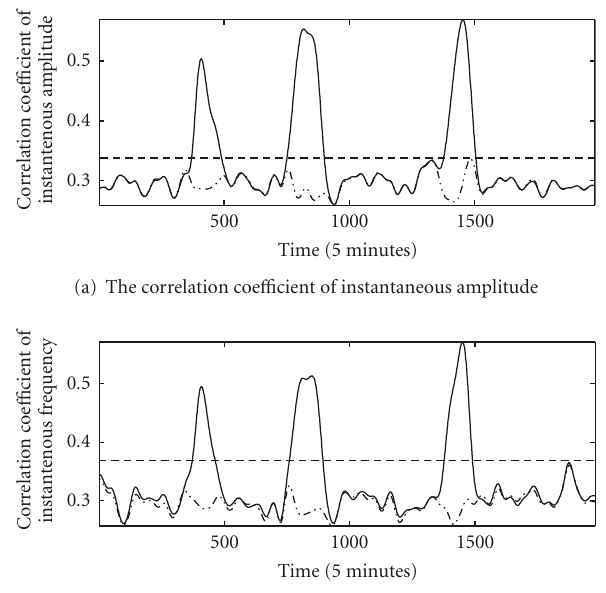
of tra ffi c ( dotted line ), because correlation parts in normal tra ffi c is erased by subtracting predictions from actual